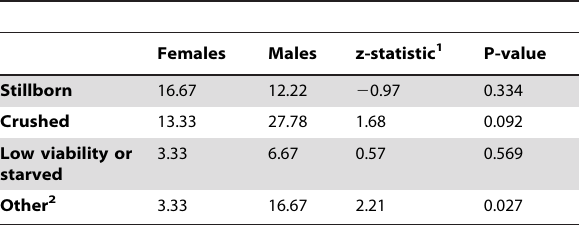
Table 1. Percentage of total number of piglet deaths classified by the different causes for each